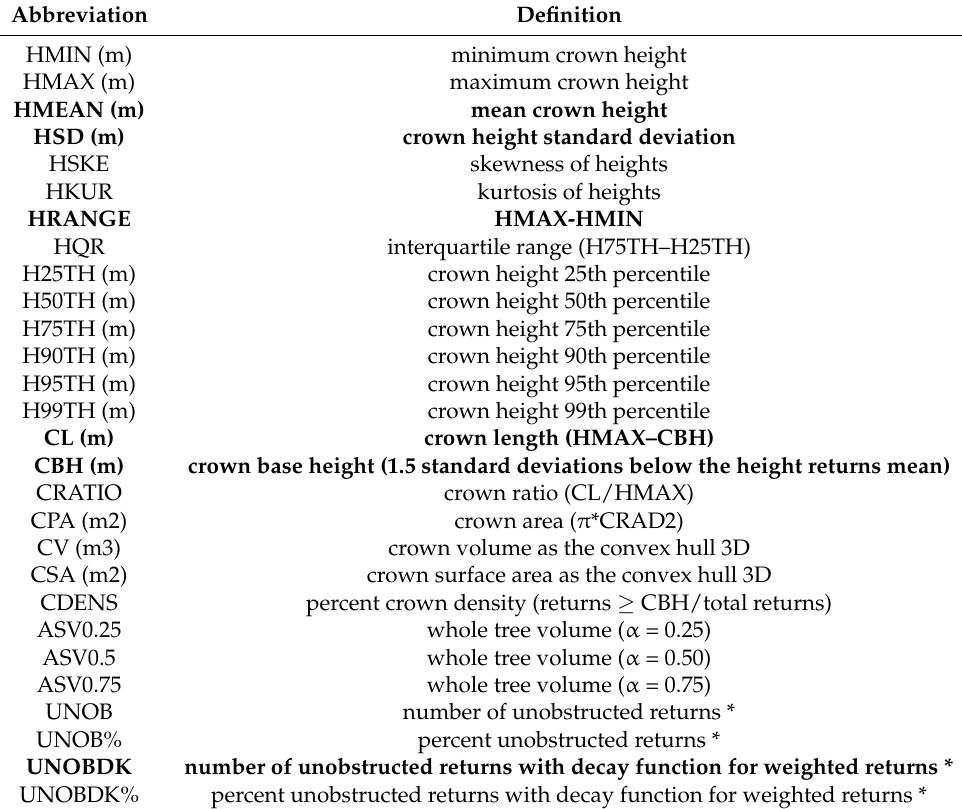
Table 1. Standard ALS-derived tree crown metrics evaluated in this study. Novel metrics used in this study indicated with a ‘*’. Bold type indicates metrics included in the final simplified